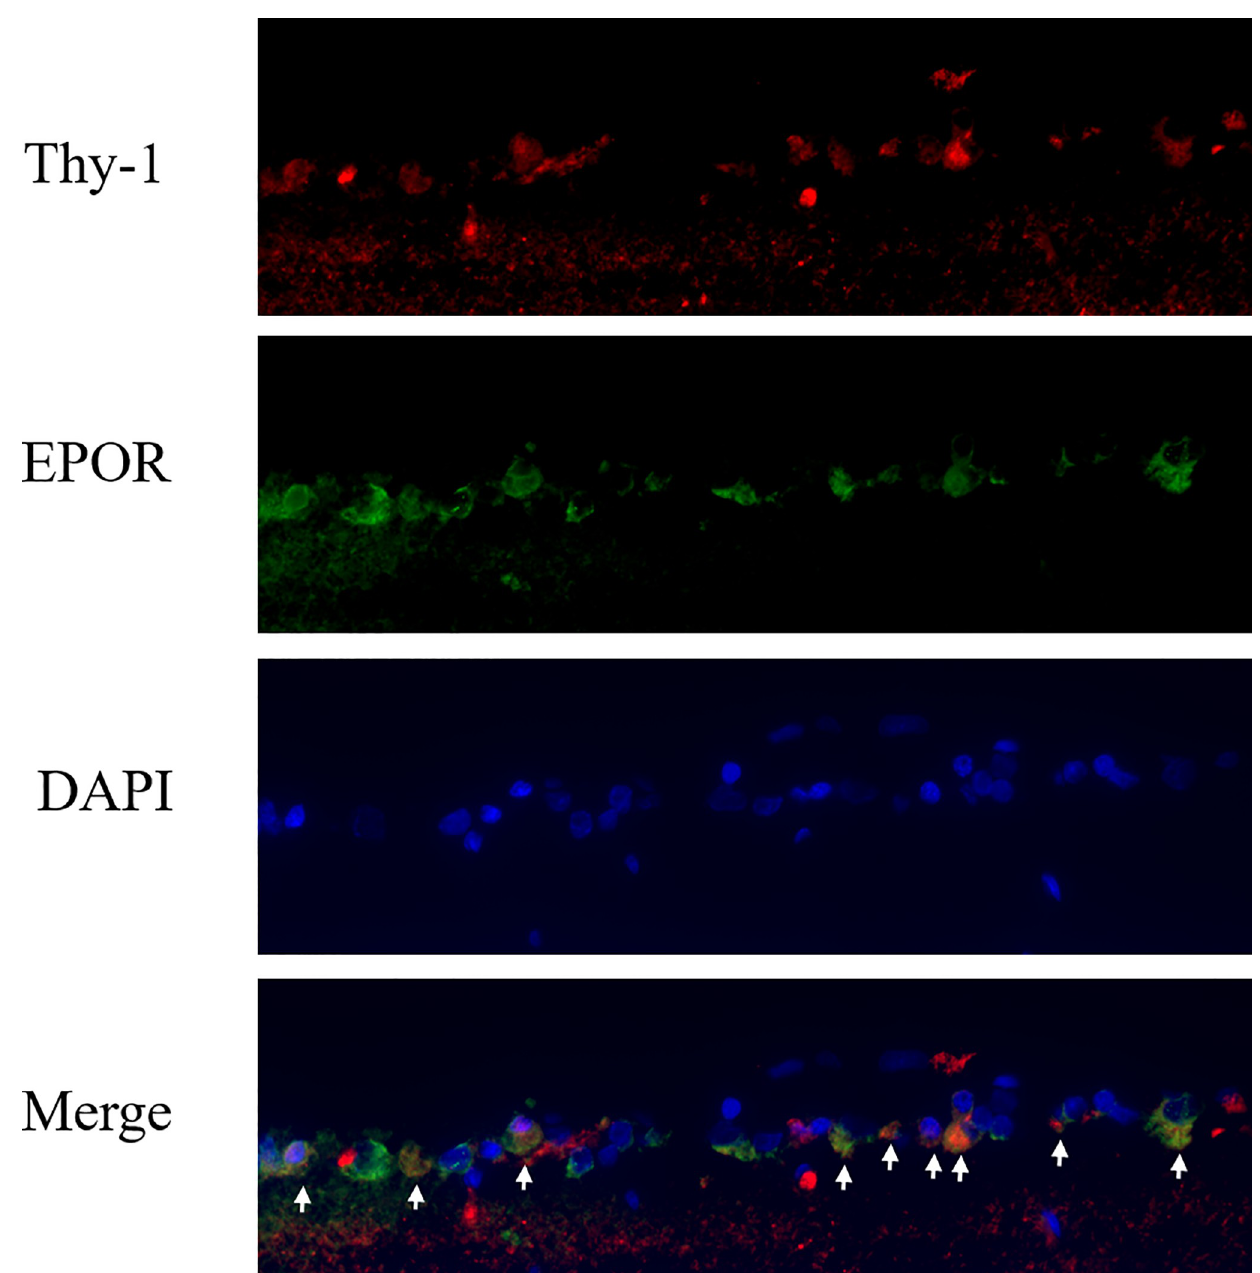
Fig 5. The immunohistofluorescence staining on the ganglion cell layers of Wistar rats: The images showed that Thy-1(red) and EPOR(green) co- expressed with nucleus stained by DAPI (blue).